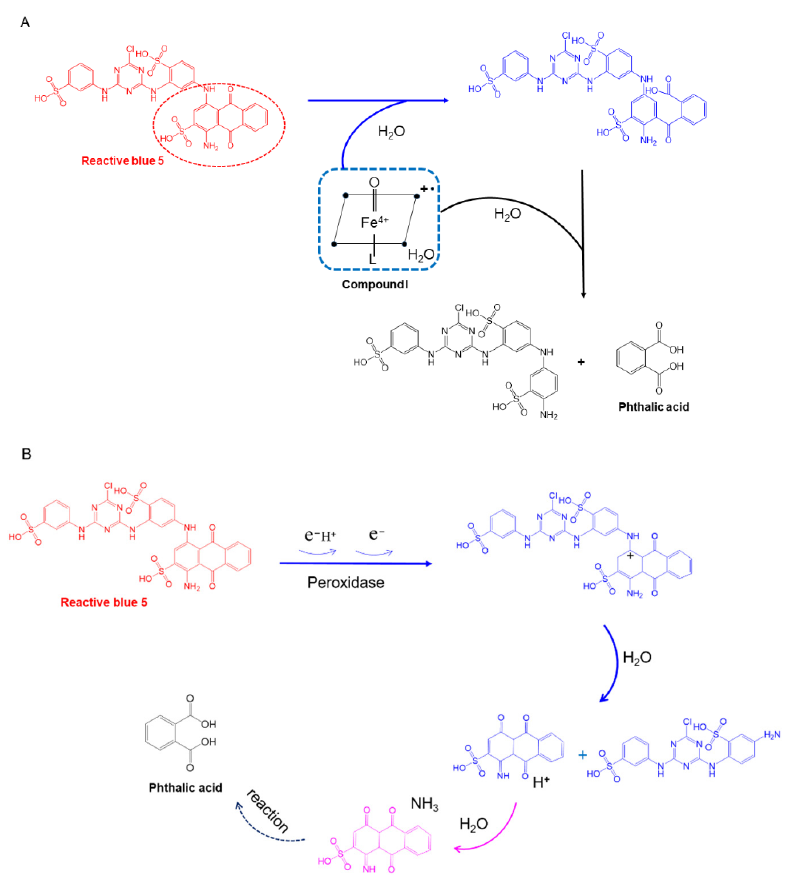
Figure 5. Two degradation mechanisms of reactive anthraquinone dyes. The red dotted circle represents anthrone, the basic functional group of anthraquinone dyes. ( A ) Mechanism of hydrolase reaction. ( B ) Mechanism of peroxidase reaction (HRP).